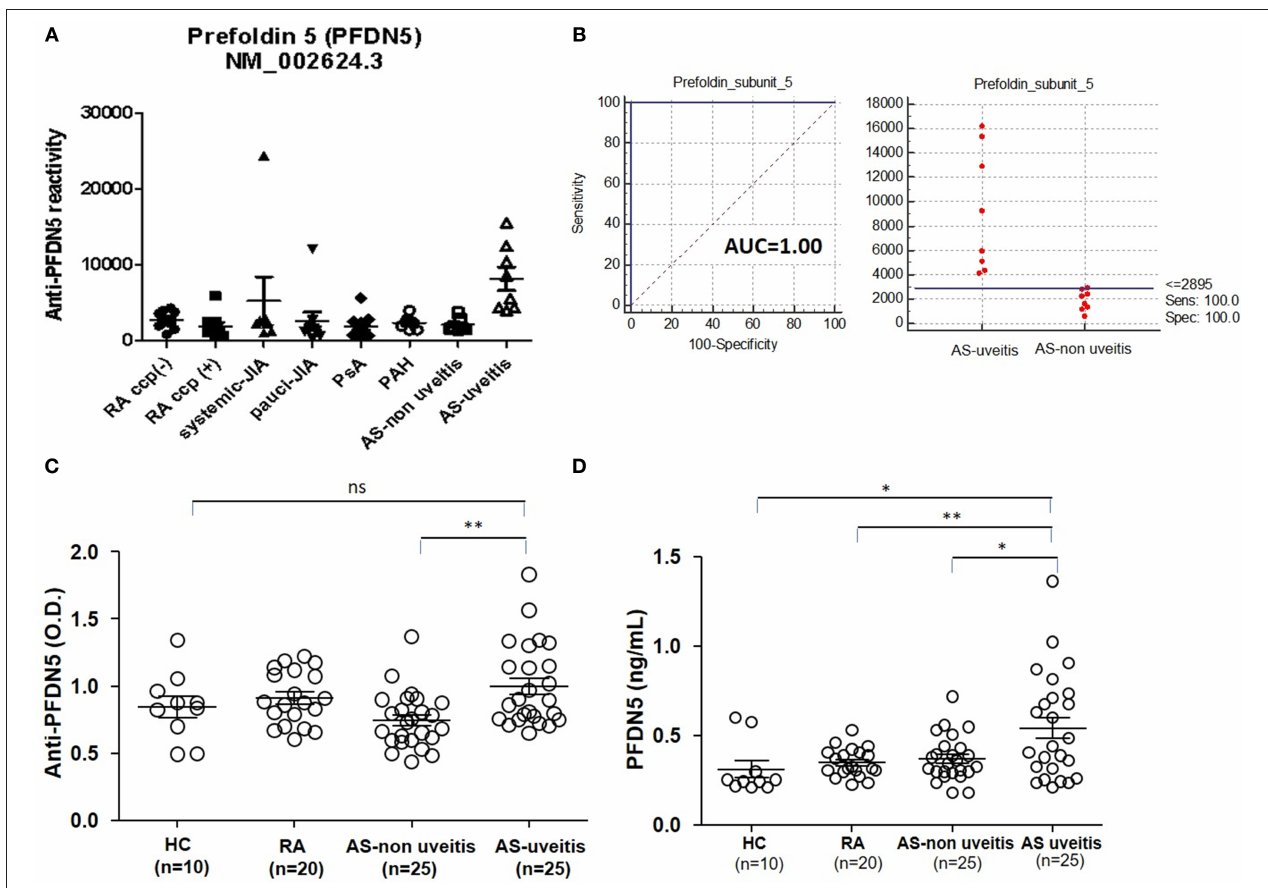
FIGURE 1 | Association between anti-PFDN5 antibody and AS with uveitis. (A) Protein microarray analysis of autoreactivity to PFDN5 in sera from patients with various autoimmune diseases in the Multiple Autoimmune Disease Genetics Consortium Cohort. (B) Receiver operating characteristic curve for anti-PFDN5 as a biomarker of uveitis in AS. (C) ELISA analysis of anti-PFDN5 antibody levels in sera from Korean cohort. (D) ELISA analysis of PFDN5 protein levels in sera from Korean cohort. Data presented as mean ± SEM. * p < 0.05; ** p < 0.01, by Mann–Whitney U -test. PFDN5, prefoldin subunit 5; RA, rheumatoid arthritis; CCP, cyclic citrullinated protein; JIA, juvenile idiopathic arthritis; PsA, psoriatic arthritis; PAH, pulmonary artery hypertension; AUC, area under the curve; HC, healthy control; ELISA, enzyme-linked immunosorbent assay; ns, not